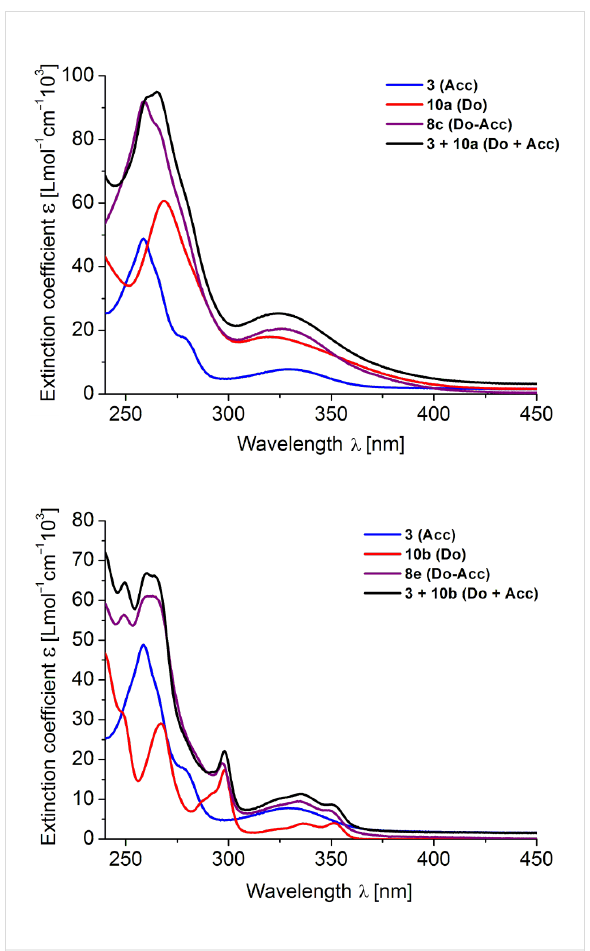
Figure 6: Absorption spectra of Do–anthraquinone dyads 8c (top) and 8e (bottom) with the corresponding references 3 and 10 , and their ad- dition spectra (Do + Acc) (recorded in CH 2 Cl 2 , T = 298